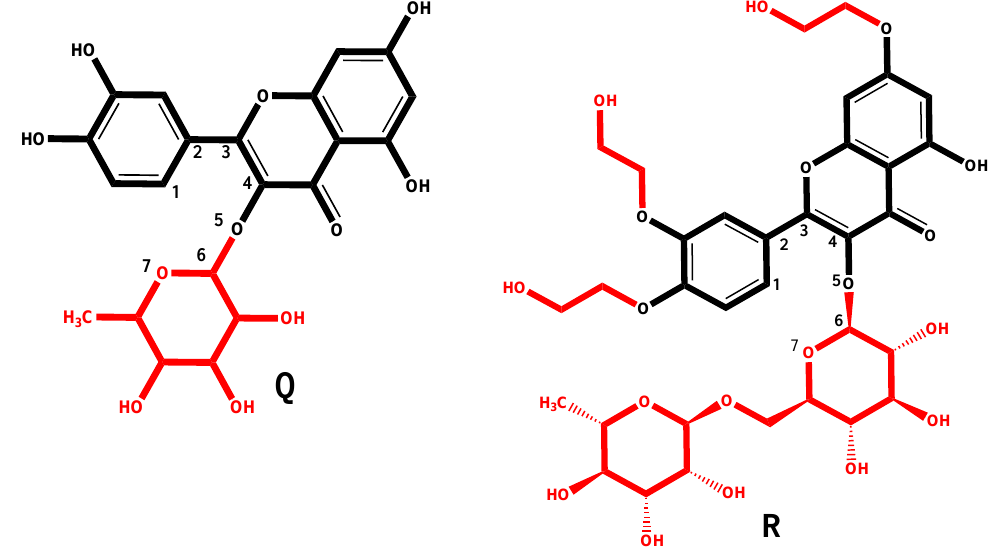
Figure 1. Geometry structures of Q and R.